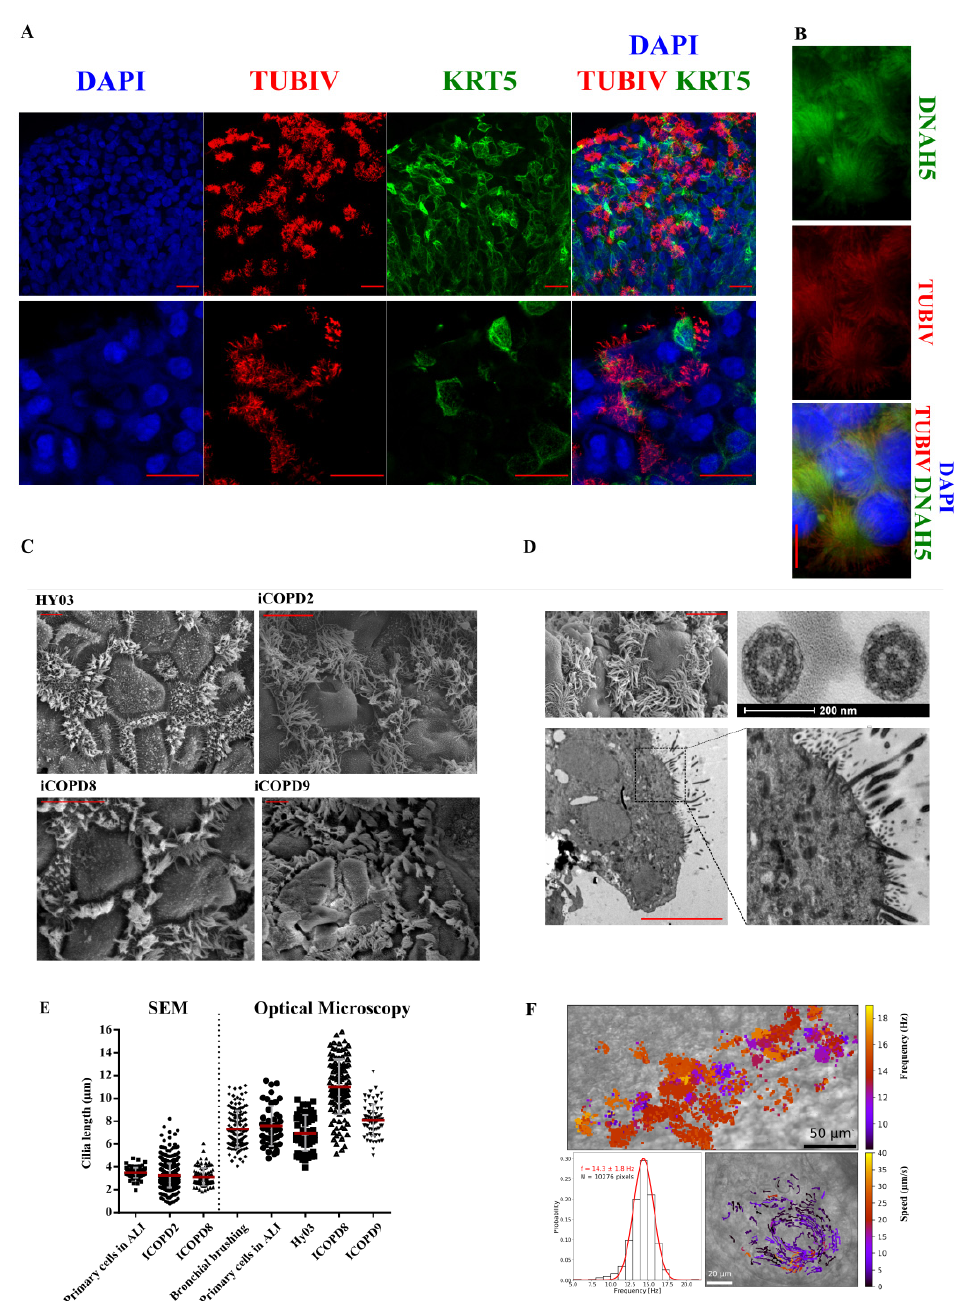
Figure 5. Multi-ciliated bronchial epithelium and cilia characterization at day 45 of differentiation. ( A ) Confocal microscopy images of TUBIV (ciliated cell marker) and KRT5 (basal cell marker) expression; iCOPD2 cell line. ( B ) Multi-ciliated cell characterization using anti-DNAH5 and -TUBIV antibodies. DNAH5 is localized in the axoneme in the iALI bronchial epithelium derived from the iCOPD9 cell line (upper panel). TUBIV is detected only in cilia (middle). Merging of the DNAH5 and TUBIV signals (lower panel); iCODP9 cell line. Scale bar: 10 µ m. ( C ) Scanning electron microscopy images of hiPSC-derived iALI airway epithelium after 45 days of differentiation showing the presence of multi-ciliated cells in iALI epithelia derived from the indicated hiPSC lines. Scale bar: 10 µ m. ( D ) Top left: Scanning electron microscopy (SEM) image of ciliated cells used for cilium length determination; iCOPD9 cell line. Scale bar: 10 µ m. Right panels: cilium cross-sections by transmission electron microscopy. ( E ) Determination of cilium length by SEM (left) and optical microscopy